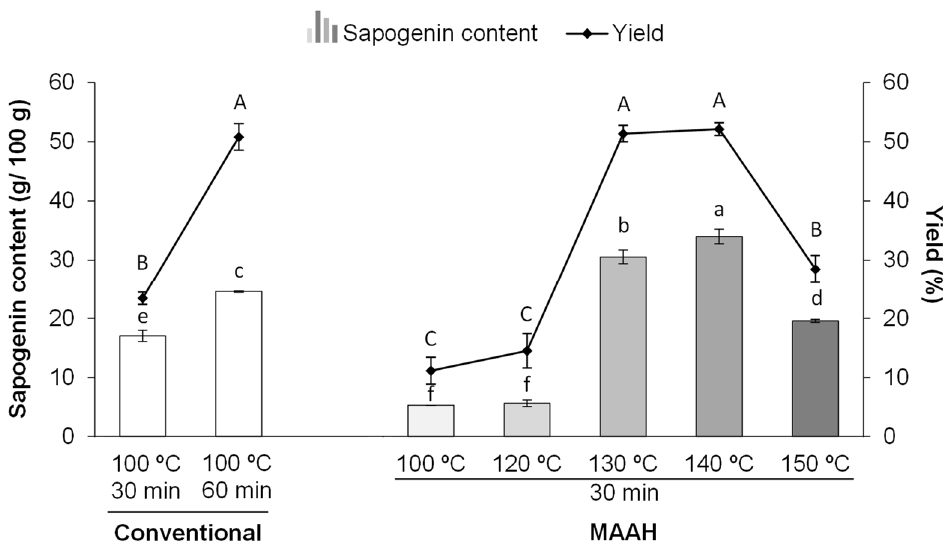
Figure 1. Sapogenin content (g/100 g) and hydrolysis extraction yield (%) of sapogenin-rich extracts obtained by conventional hydrolysis and microwave-assisted acid hydrolysis (MAAH) at different temperatures. Standard deviations are indicated by error bars. Mean values with different letters (A–C, yield; a–f, sapogenin content) are significantly different ( p ≤ 0.05).